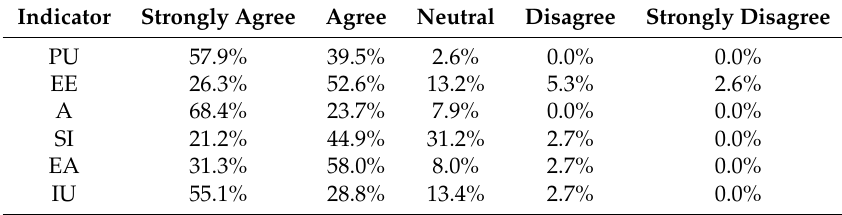
Table 4. Results with a Five-Point Liker-Type Scale from the Survey for Academic Year 2018–2019.